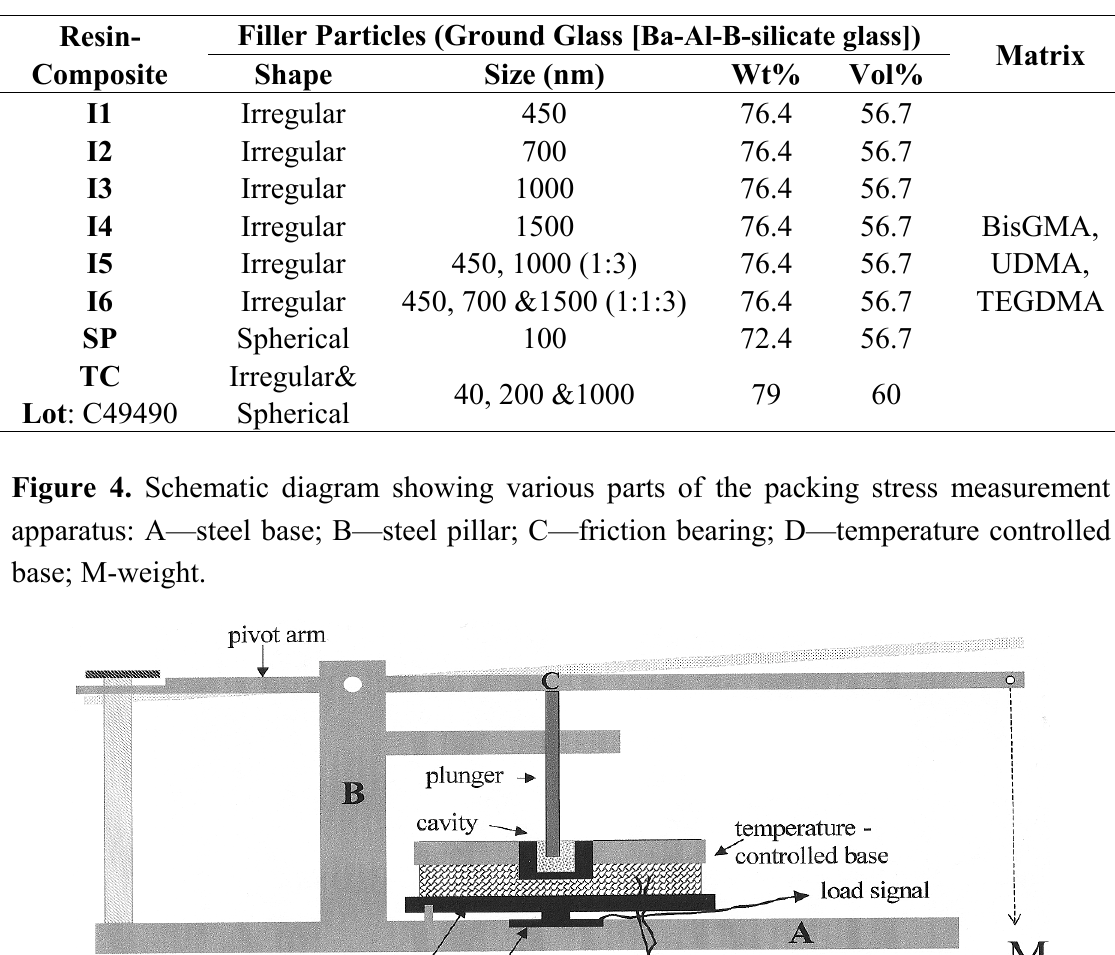
Table 3. Composition of resin composites used in the study.